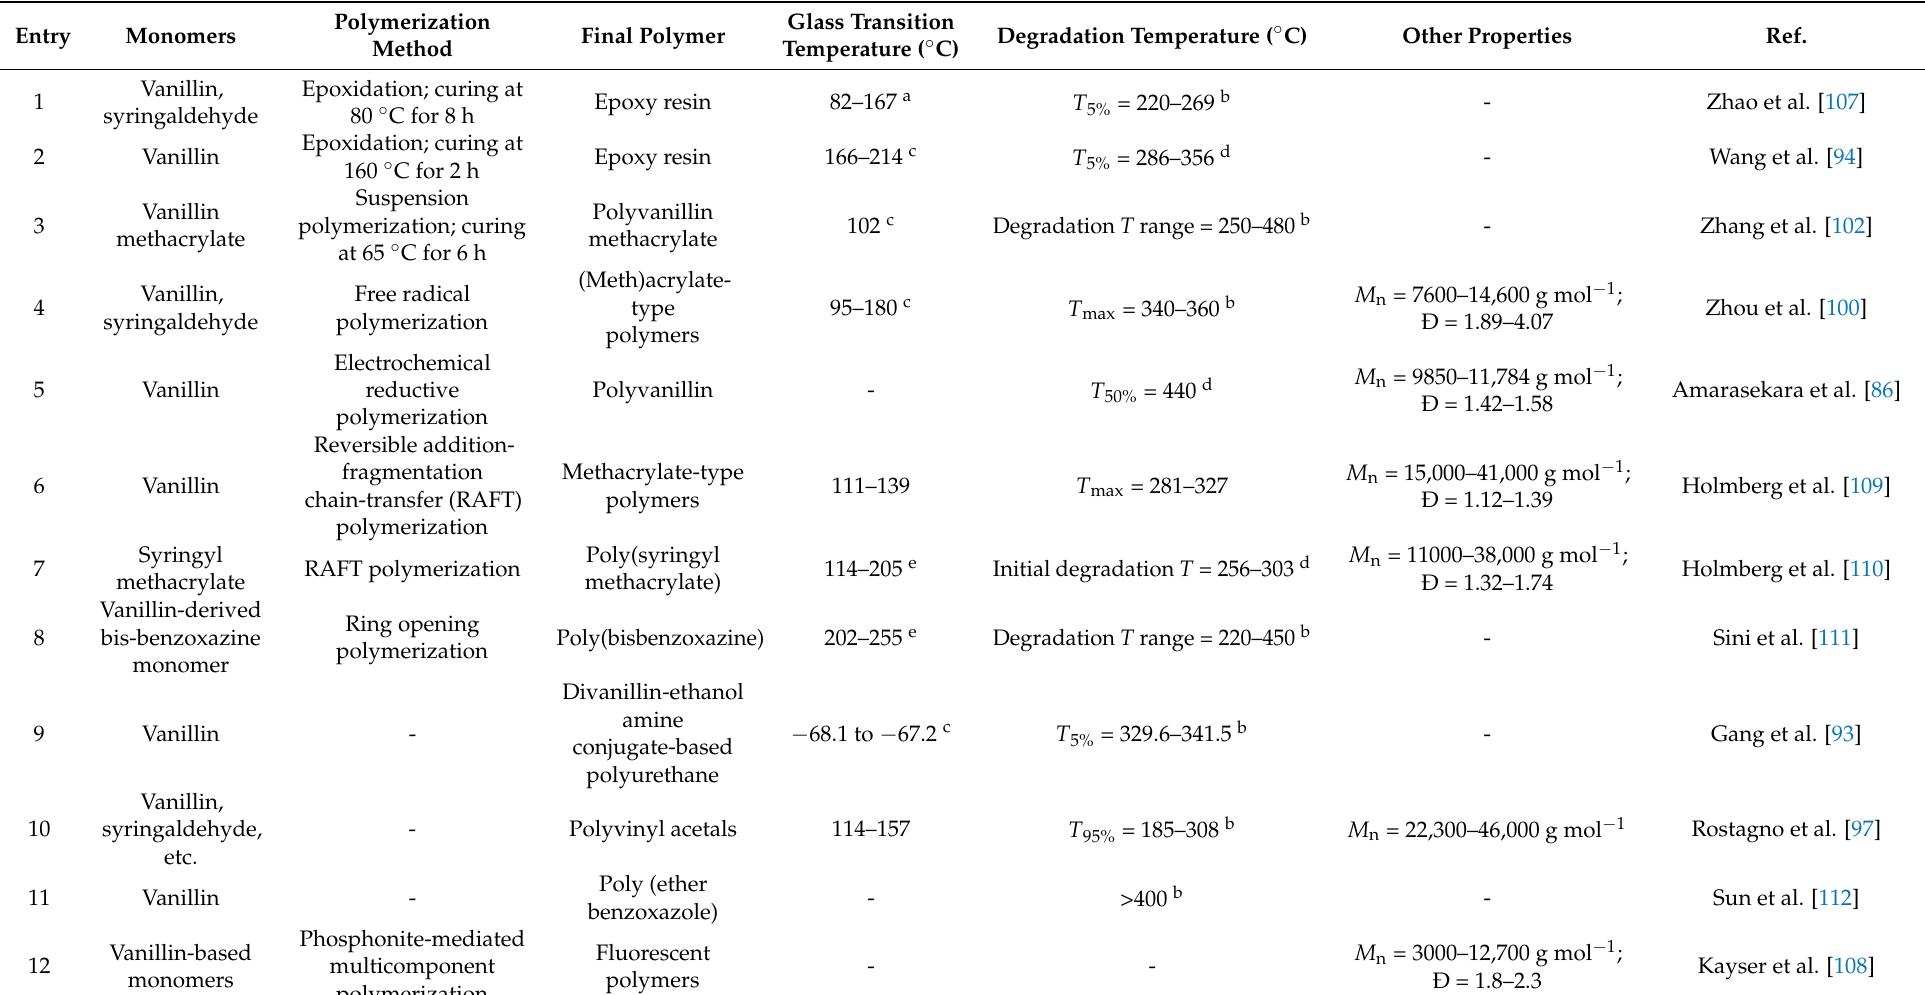
Table 2. Thermomechanical properties of vanillin- and syringaldehyde-derived